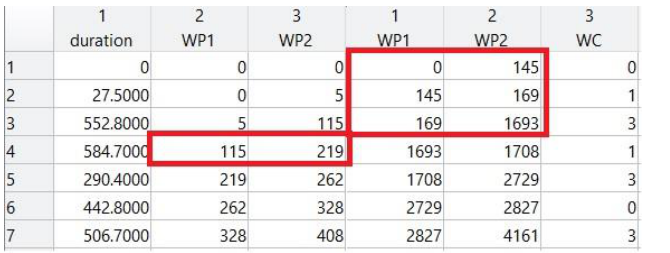
Figure A1. Problem of unequal coverage of waypoints of way category and duration (own representation).